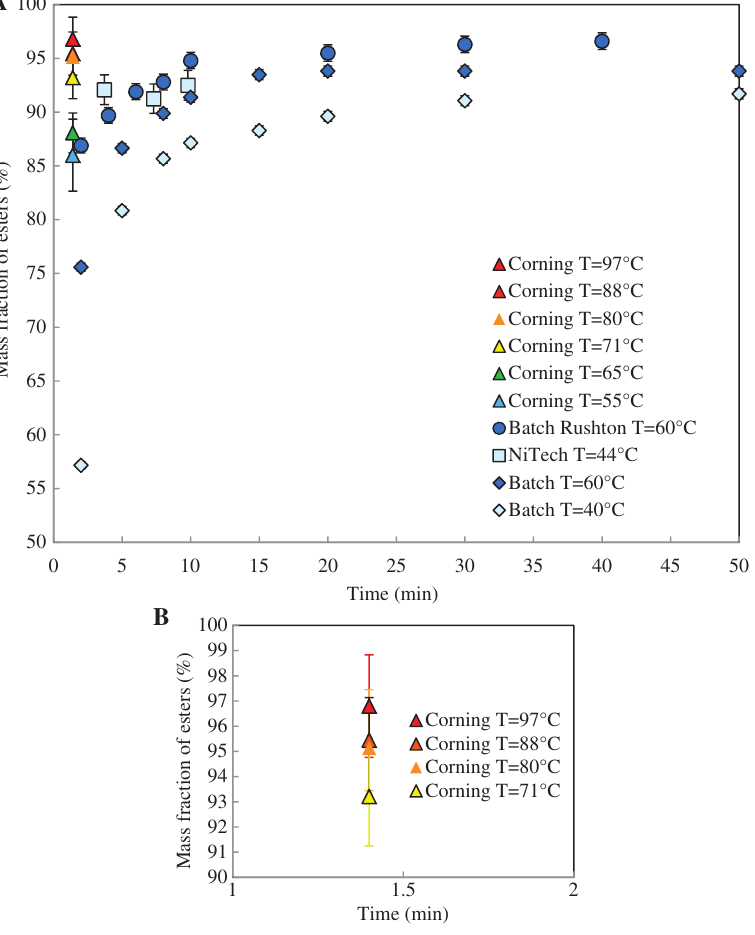
Figure 7 (A) Comparison of the time evolution of methyl ester mass fraction in the batch, Corning and NiTech reactors. (B) A zoom has been made for Corning results at high temperatures.